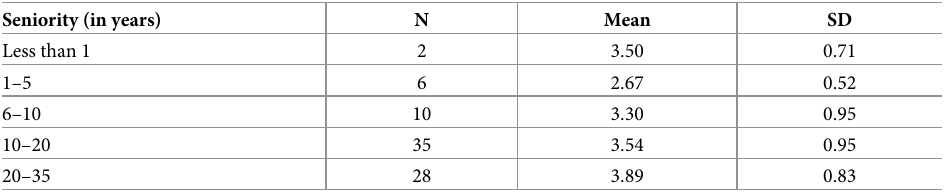
Table 3. One-way ANOVA for differences in professional experience in the organization and improvement of knowledge management on a personal level. Seniority (in